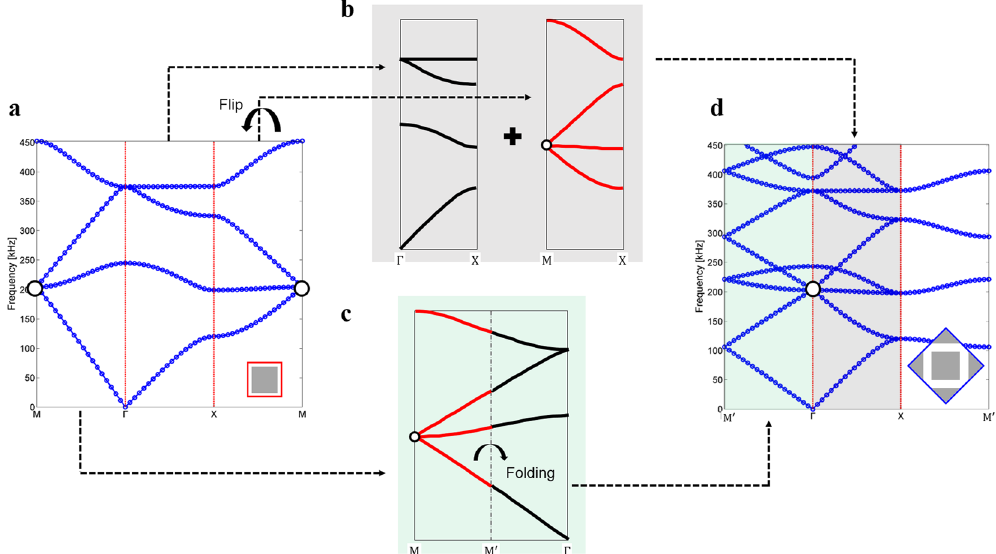
Figure 2. Band structures for the three types of unit cells and related folding mechanisms: ( a) Band structure of unit cell type O and (b , c) zone-folding mechanism when the unit cell is enlarged. (d) Band structure of unit cell type